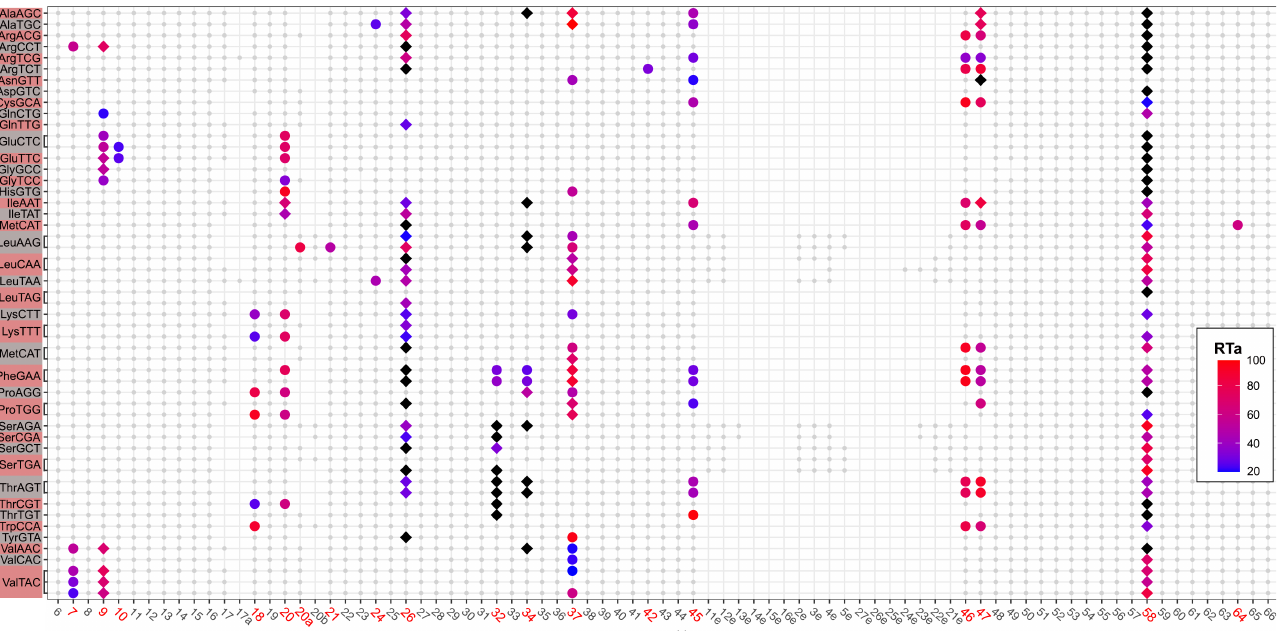
Figure 3. Overview of modification patters in Dictyostelium discoideum tRNAs shown for 0h after starvation as an example. The tRNAs are ordered by isoacceptor family and anticodon with one line for each distinct tRNA sequence and aligned according to Sprinzl’s nomenclature for nucleotide positions [54]. Gray background dots indicate nucleotides present in a sequence. Colored marks indicate the RTa intensities (fraction of reads that stop at position n + 1). Colored (cid:7) symbolizes tRNA positions that show both RTa and misincoorperation sites, while the symbol in black refers to tRNA positions that show only misincoorperations. • show positions derived by their RTa profile. Only tRNAs with detectable modifications are included. The full set and other time points are listed in Table S2.